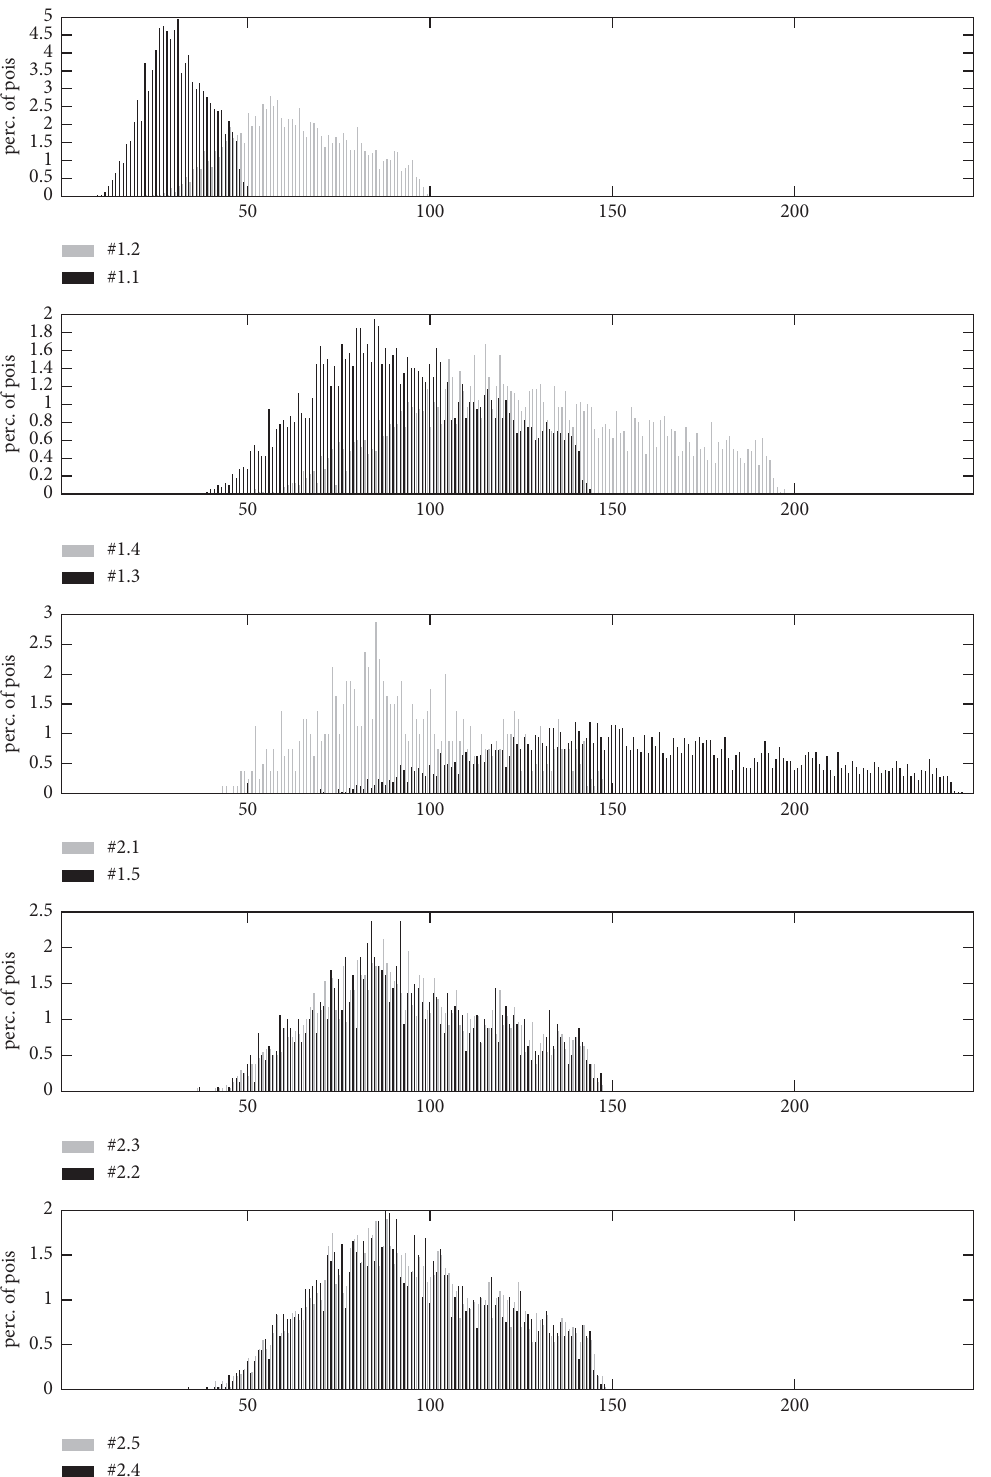
Figure 11: Percentage numbers of POIs covered by diferent numbers of sensors for the benchmark given in